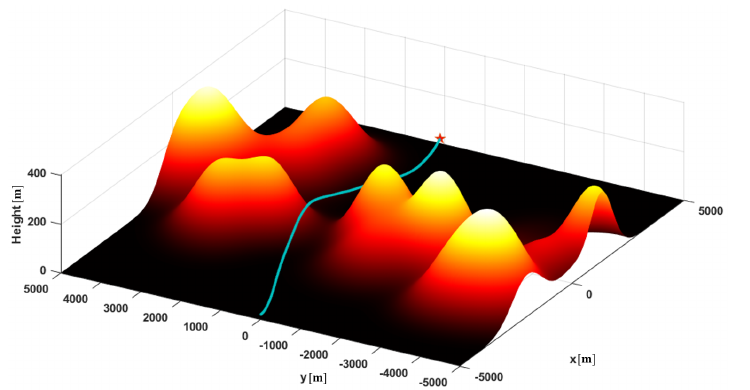
Figure 15. The trajectory of scenario B.